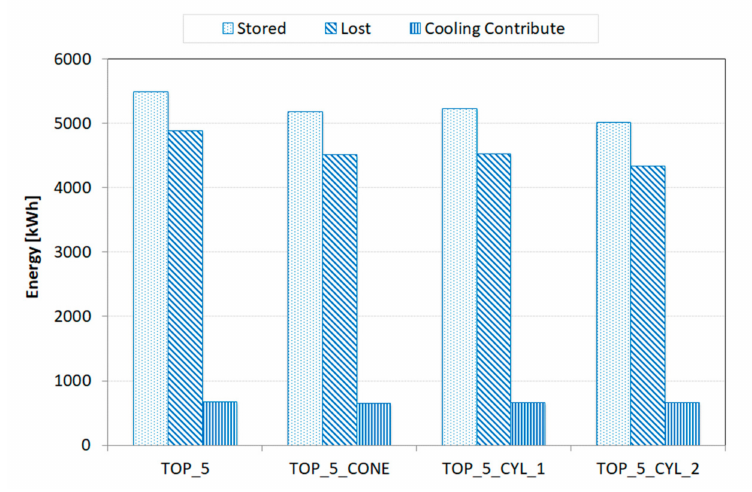
Figure 12. Energy analysis of the